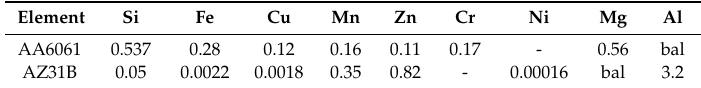
Table 1. Compositions of Al and Mg alloys (wt%).